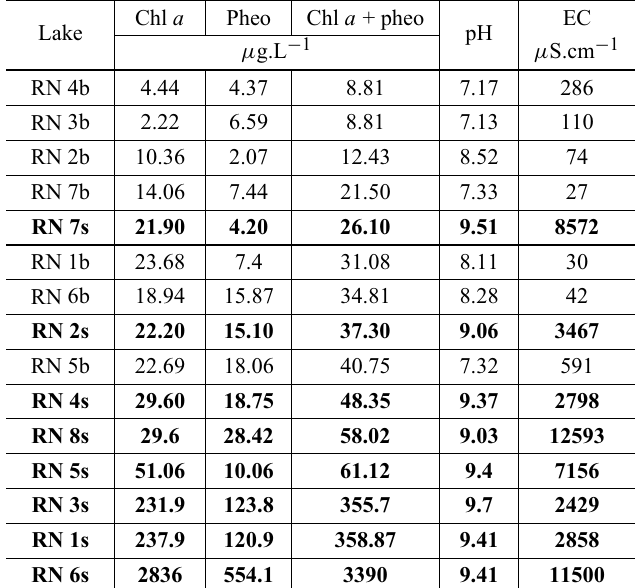
Pigments in phytoplankton (chlorophyll a and pheophytin), pH and EC. Bold characters: samples with pH > 9. The data are ordered by the sum of the chlorophyll a + pheophytin